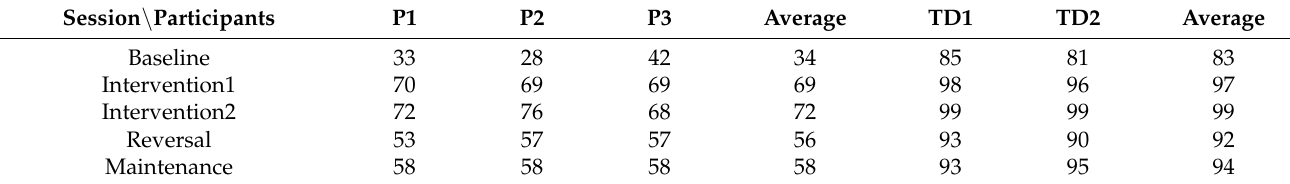
Table 2. Intervention and evaluation